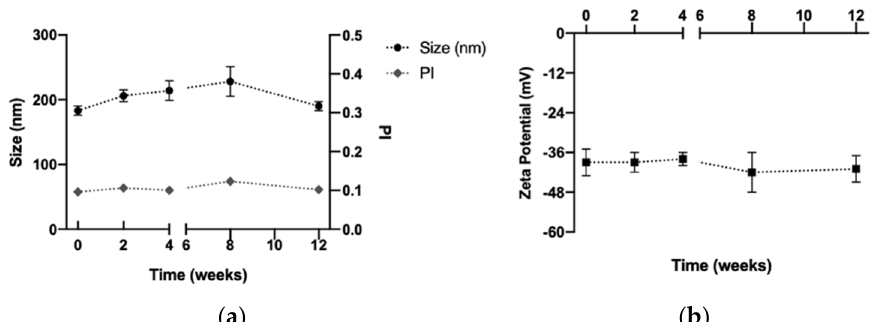
Figure 8. Stability of the dextran nanocapsules with imiquimod in their core (DX NC ‐ imq*) sub ‐ jected to freeze ‐ dry with glucose at 10% and stored at 4 °C. ( a , b ) Size, polydispersity index and zeta potential of DX NC ‐ imq* freeze ‐ dried with glucose at 10%, respectively. PI: polydispersity index. * Formulation elaborated applying high manual pressure. (Mean ± SD, n = 3).